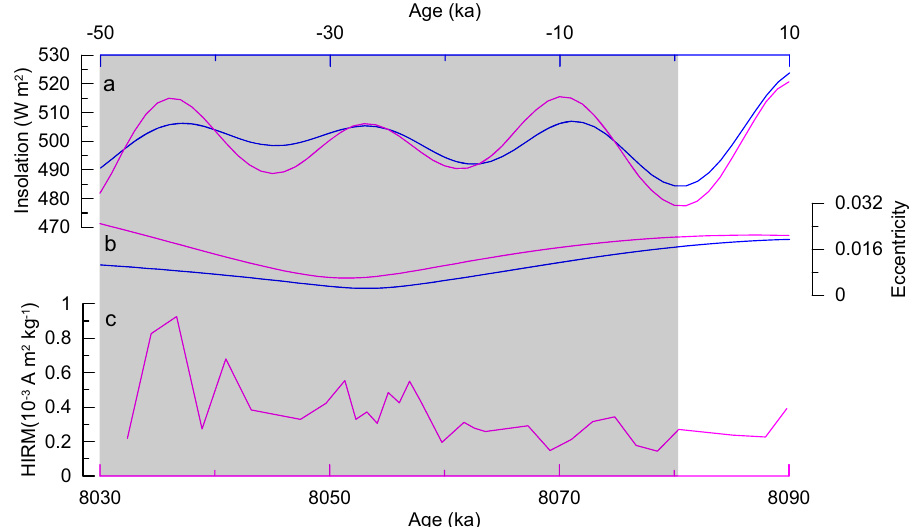
Fig. 4 Summer insolation and eccentricity over 8.09 – 8.03 Ma compared with present and future con fi guration and the HIRM time series. a Summer insolation comparison between the intervals of 8.03 – 8.09 Ma (purple) and from 10 ka to future 50 kyr (blue). Both records are June 21 insolation from 40°N 24 . b Eccentricity comparison between the intervals of 8.09 – 8.03 Ma and from 10 ka to future 50 kyr 24 . c HIRM from Tarim over 8.09 – 8.03 Ma. We used the tuned age model for the Tarim record, with tuning tie points shown by blue arrows in Fig. 2. The gray bar highlights the interval of low amplitude insolation variations for the next 50 kyr, similar to those during 8.08 – 8.03